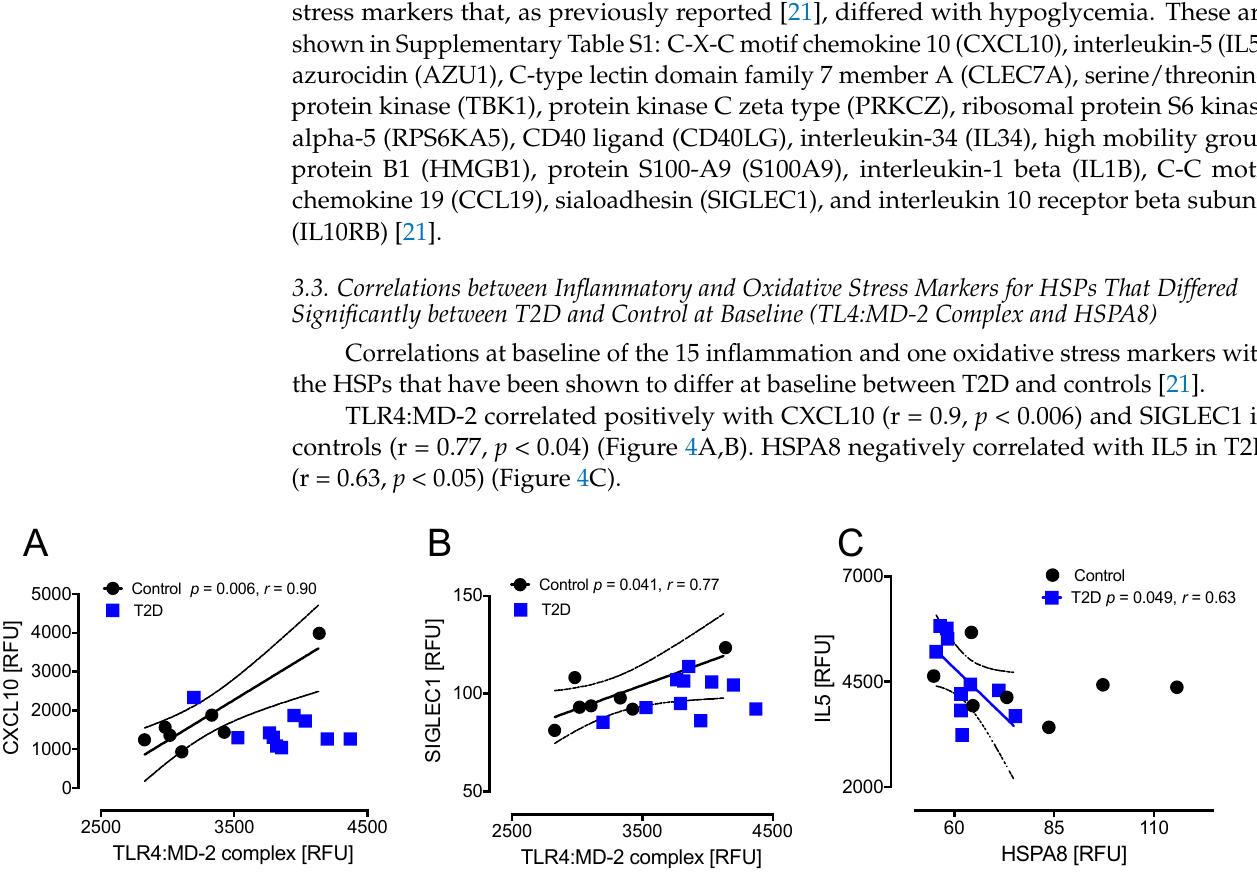
6 of 16 Figure 3. Comparison of plasma levels of the following heat shock proteins: ubiquitin-conjugating enzyme E2N (UBE2N), stress-induced phosphoprotein 1 (STIP1), and ubiquitin-conjugating enzyme E2L3 (UBE2L3) at baseline (BL), at hypogly- cemia, and 24 h post hypoglycemia in control and T2D cohorts. Controls (white circles), T2D (black squares). UBE2N ( A ), STIP1 ( B ), and UBE2L3 ( C ), proteins for which levels differed from baseline to hypoglycemia in T2D and control cohorts. Statistics: $, p < 0.05, T2D BL vs. Hypo; &, p < 0.05, control BL vs. 24 h. RFU, relative fluorescent units; Hypo, hypoglycemia. 3.2. Proteins That Differed between T2D and Control at Baseline and at Hypoglycemia At baseline, TLR4:MD-2 complex was higher ( p = 0.01), whilst HSPA8 was lower ( p < 0.05) in T2D (Figure 2A,B). At hypoglycemia, TLR4:MD-2 complex and HSPA8 both decreased in T2D versus